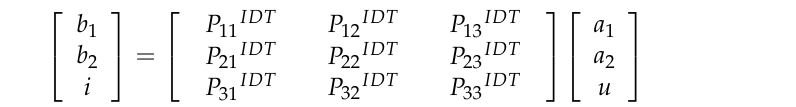
P matrix element of the